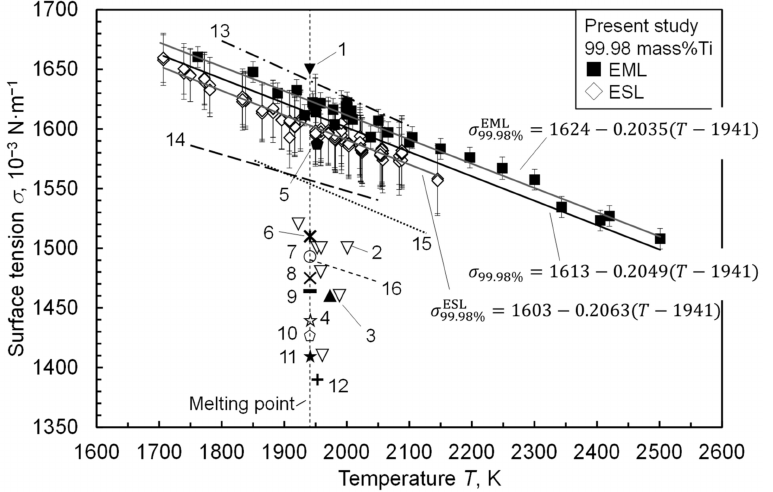
Figure 4. Comparison of the measurement results of the surface tension of liquid titanium with purity of 99.98 mass % by EML and ESL together with the literature data [1–16]. The averaged surface tension of liquid titanium from the measurement result by EML and ESL is expressed as